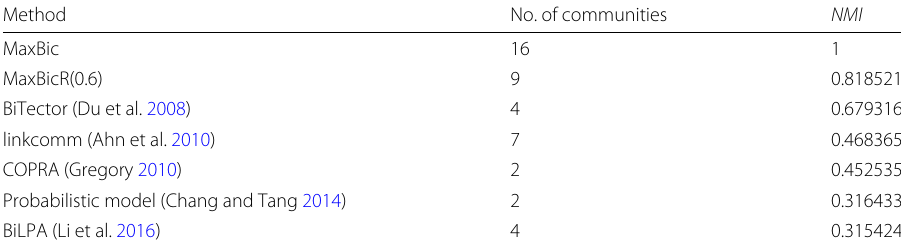
Table 3 Comparisons of MaxBic metadata communities with MaxBicR(0.6) and five other methods for detecting overlapping communities of Women and Events ( P ∨ S ) Method No. of